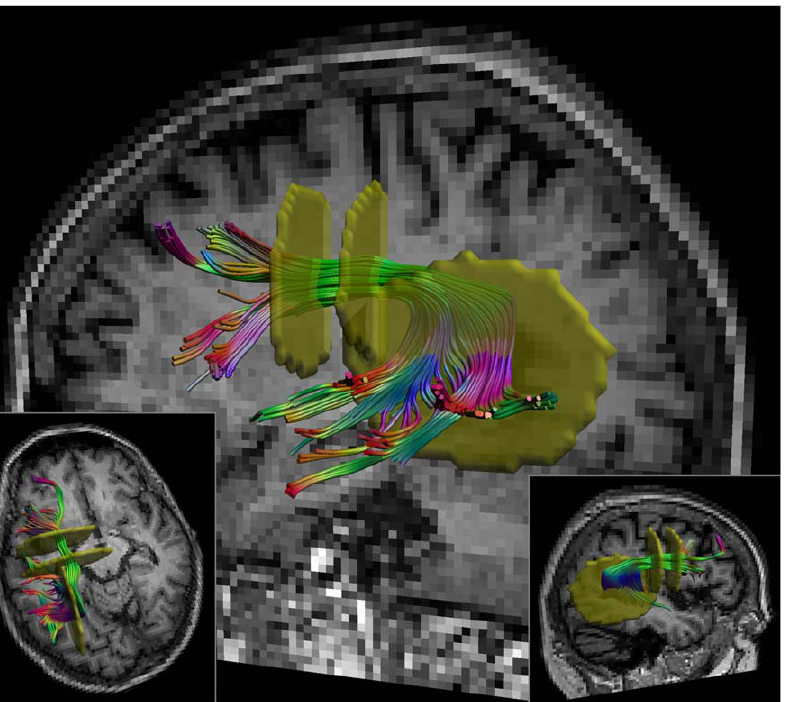
Figure 1. Selection of the superior longitudinal fasciculus (SLF). The SLF was selected using a multiple region of interest (ROI) approach. Two ‘‘AND’’ ROIs (shown in yellow) were placed on a coronal slice and one on a sagittal slice. Reconstruction was based on a standardized atlas of white